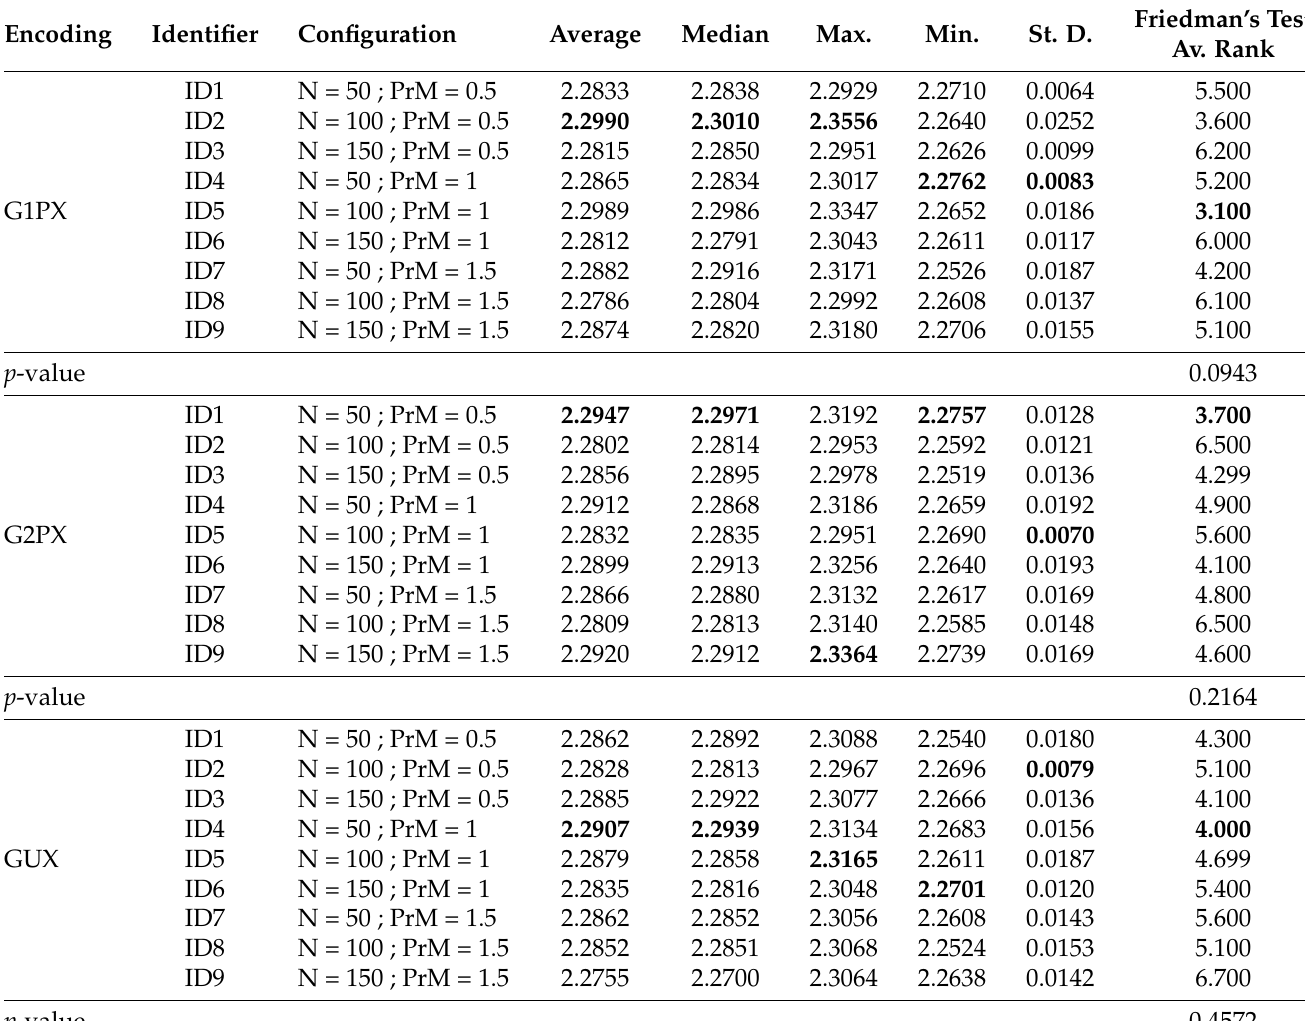
Table 6. Hypervolume Statistics (Gray Encoding).